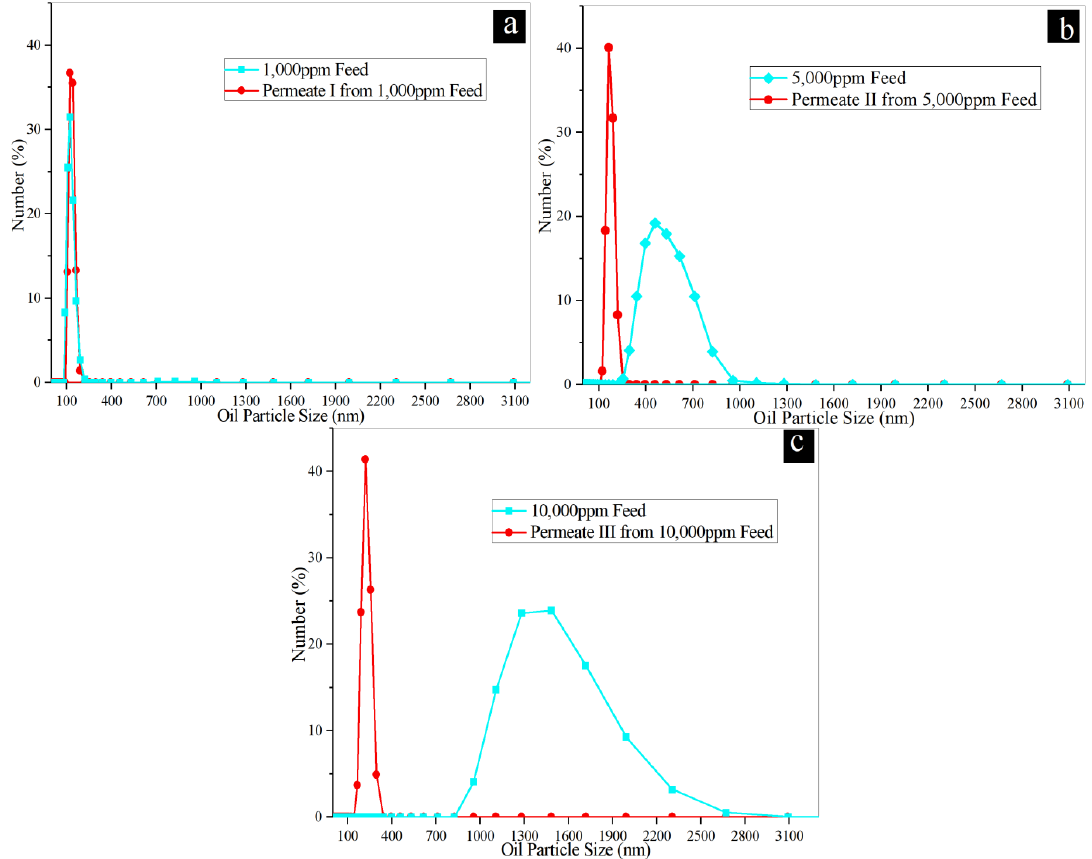
Figure 6. The oil particles (size distribution by number) of the synthetic oily saline wastewater at ( a ) 1000 ppm, ( b ) 5000 ppm and ( c ) 10,000 ppm as feedwater and the permeation of each concentration by the 2TNS-TFN membrane.